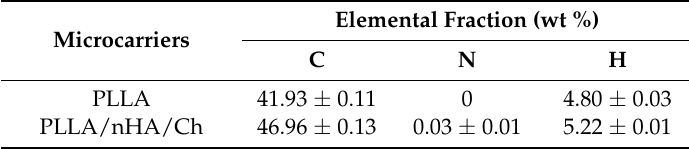
Table 2. Nitrogen content of microcarriers measured by an elemental analyzer.